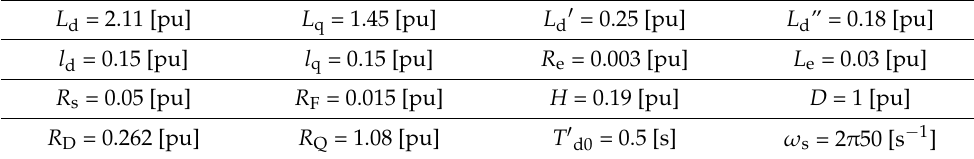
Table 8. Synchronous generator’s data obtained with